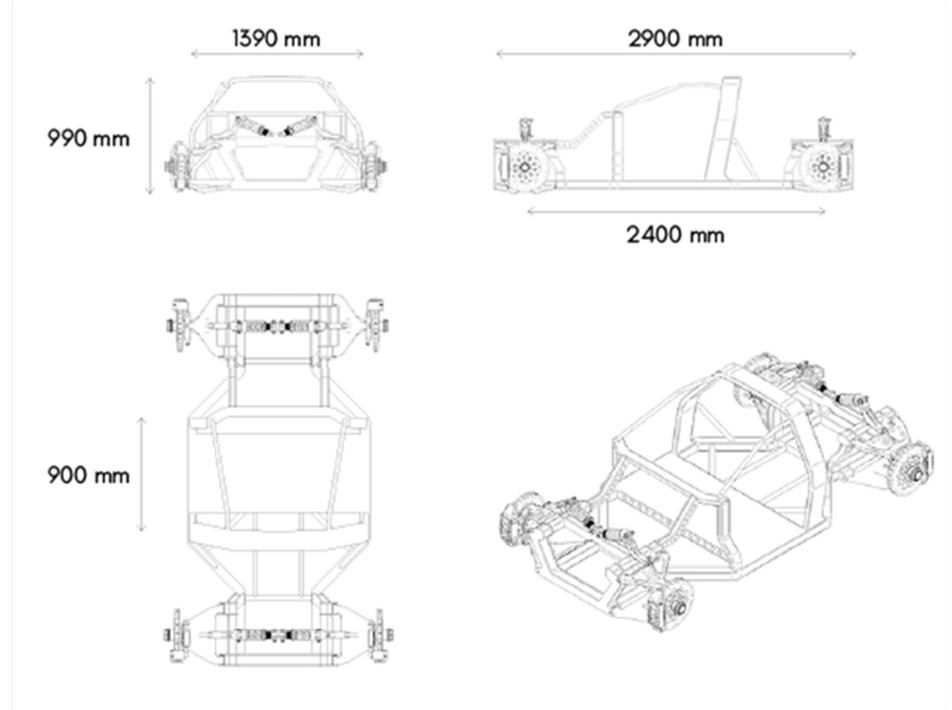
Figure 22. Chassis Assembly 2D Drawings.